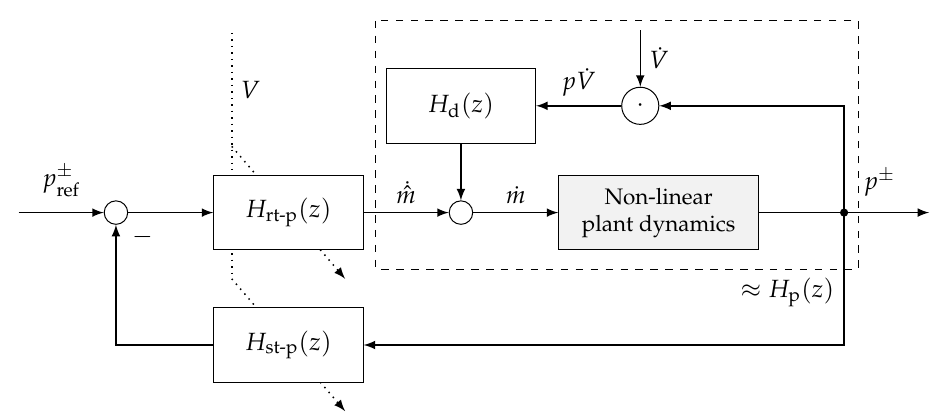
Figure 6. Pressure controller with two degrees of freedom and disturbance cancellation